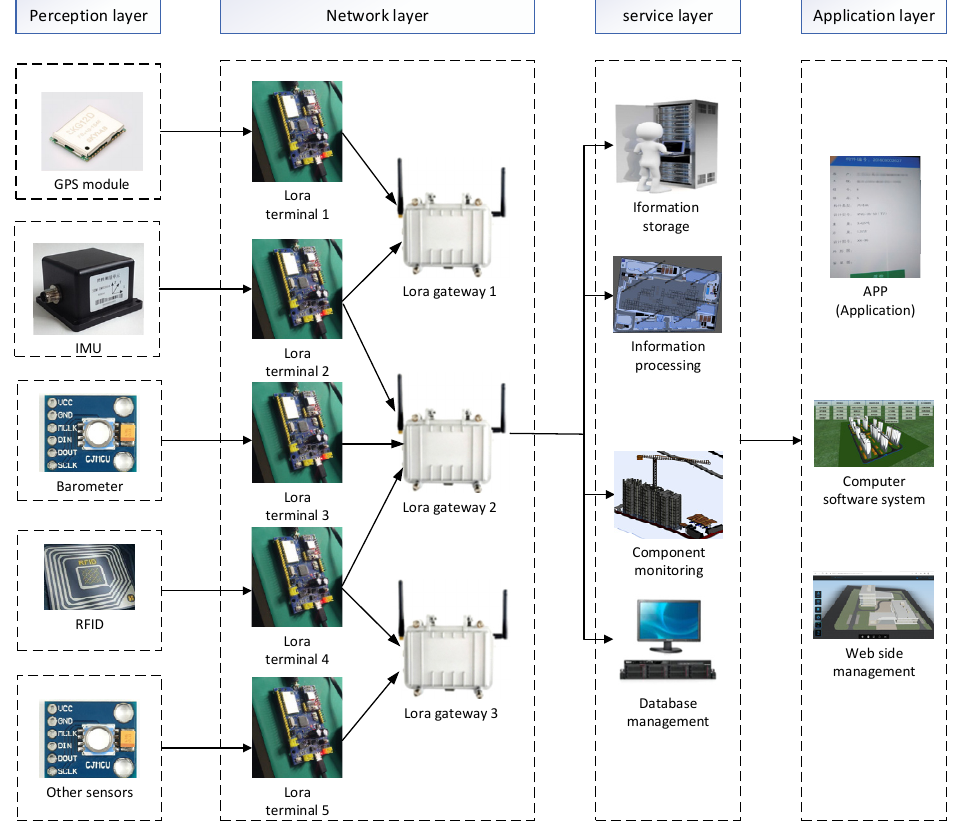
Figure 5. Hoisting monitoring method architecture based on LoRa WAN.